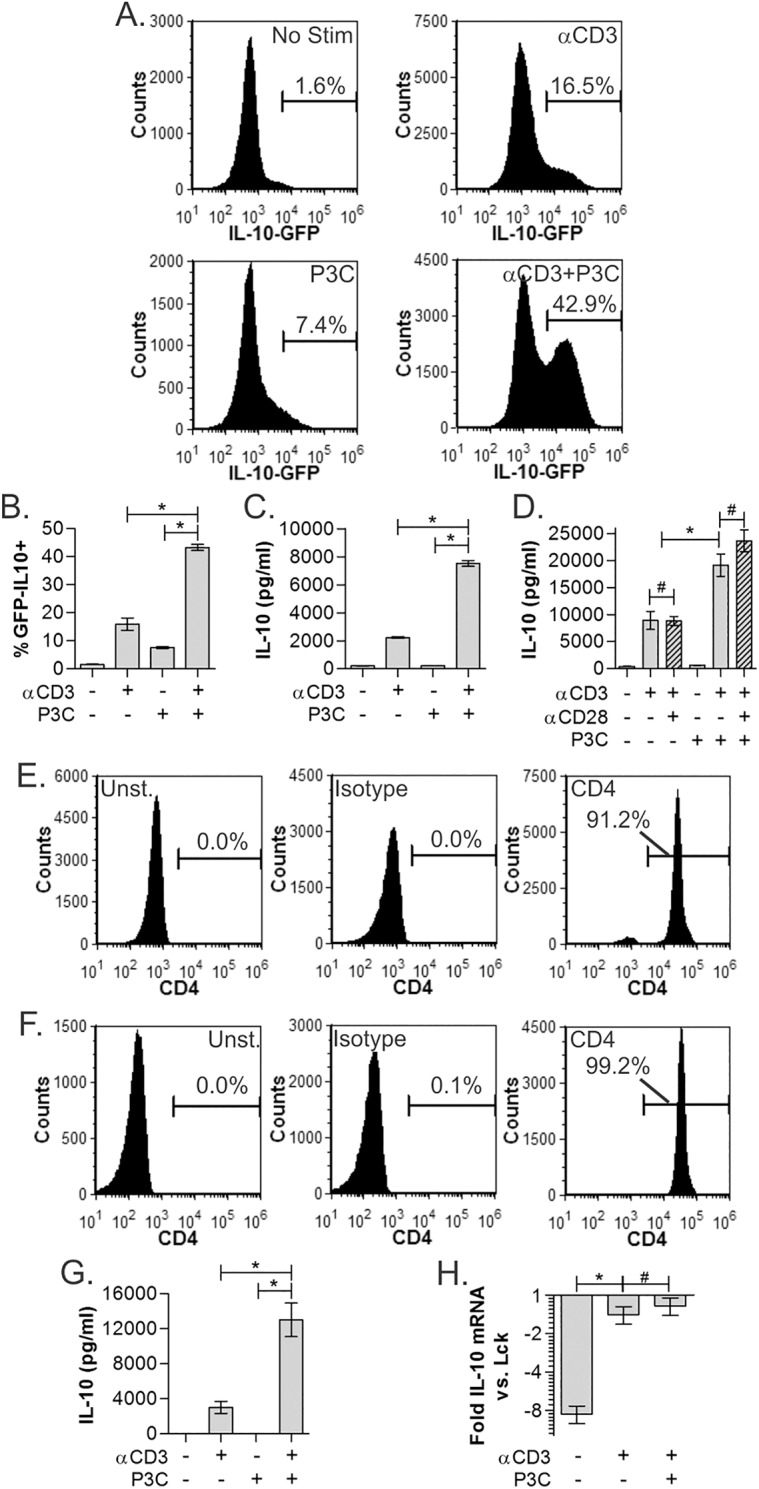
TCR and TLR co-stimulation promotes synergistic IL-10 production.Splenic CD4+ T cells isolated from an IL-10 (IRES-GFP) reporter were stimulated with TCR (αCD3) and TLR2 receptor agonists (Pam3Csk4, P3C) independently or in combination at 2μg/ml each. IL-10 expression was measured on day 3 by flow cytometry as % GFP positive within CD4+ gated cells. Representative histograms (A) and replicates (B) show synergistic IL-10 response to simultaneous TCR/TLR2 co-stimulation above either stimulus independently. (C) WT C57Bl/6 splenic CD4+ T cells were cultured as above and IL-10 quantified by ELISA on day 3, showing synergistic IL-10 secretion. (D) WT CD4+ T cells cultured with αCD3 and/or P3C as before, with and without αCD28. IL-10 synergy is not significantly impacted by the addition of CD28 stimulation. (E) Magnetic bead-isolated (MACS) CD4+ T cells used in panels A-D by flow cytometry showed 91.2% purity. (F) Sterile flow cytometry-sorted (FACS) CD4+ T cells showed 99.2% purity. (G) IL-10 secretion of ultra-pure FACS sorted CD4+ T cells (see panel F) stimulated as before, showing indistinguishable synergy from MACS-isolated T cells (see panel C). (H) mRNA transcript levels of the IL-10 gene from stimulated WT CD4+ T cells was measured by microarray. Normalized expression levels compared to the canonical T cell marker Lck are shown, showing that αCD3 induces transcription of the IL-10 to an equal extent as with added P3C, suggesting P3C controls IL-10 concentration through regulation of IL-10 translation. All data are n≥3, unless otherwise noted; *p<0.05; #p>0.05.